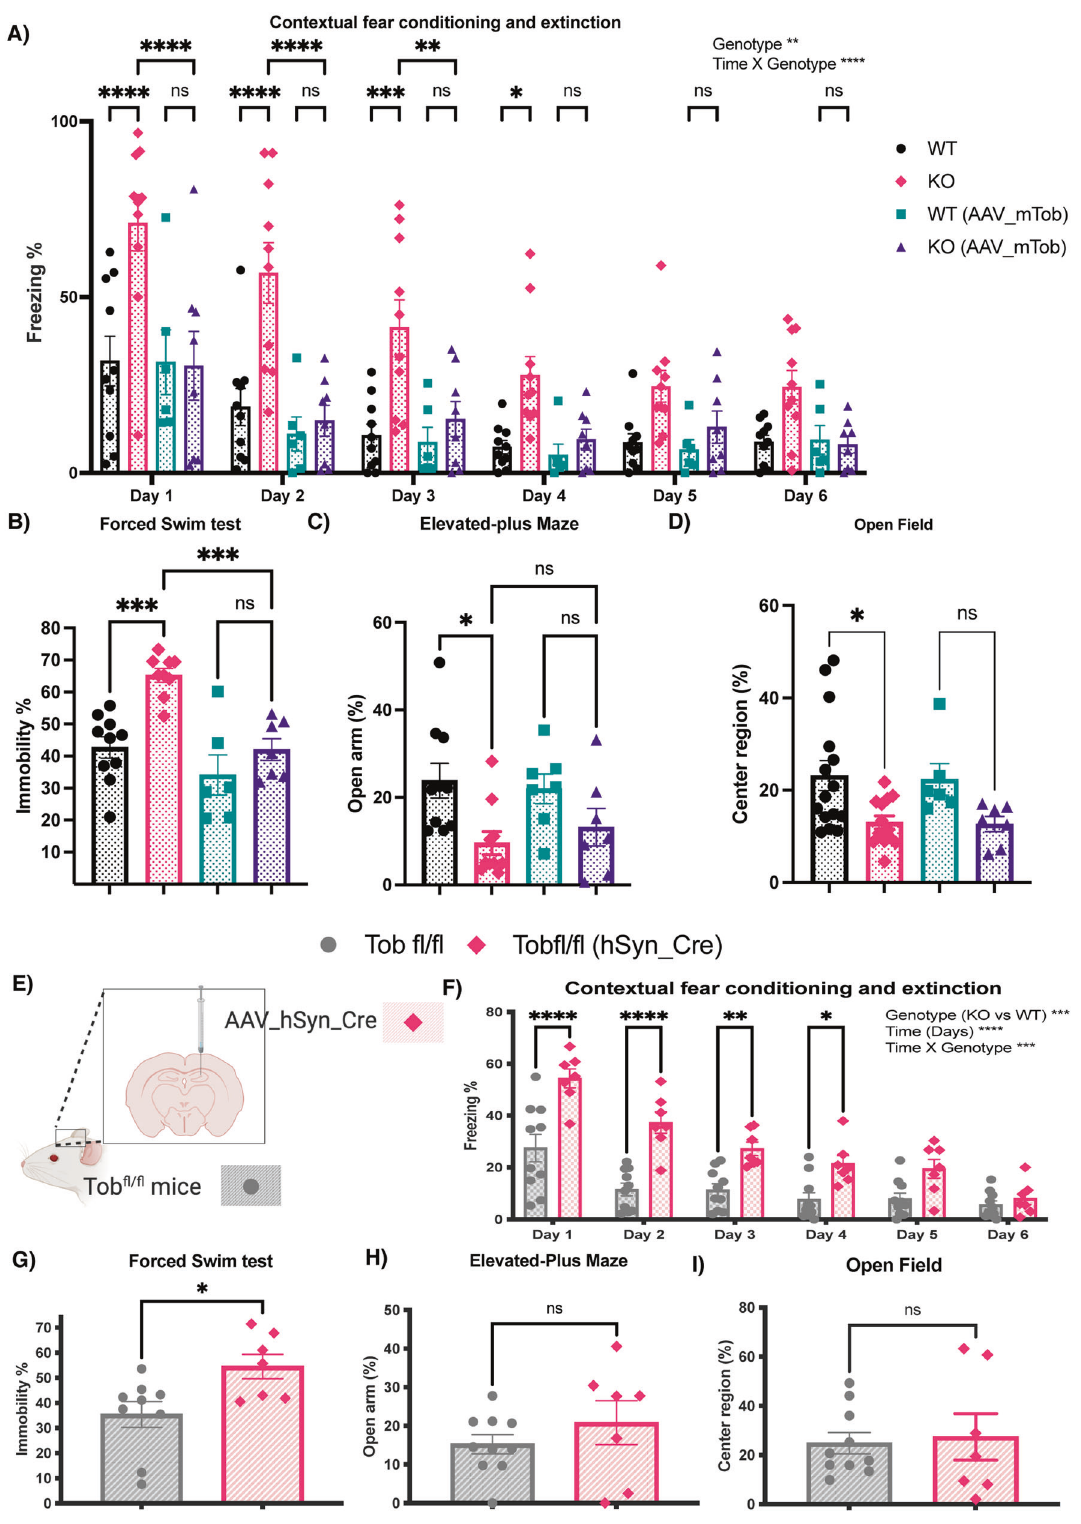
Additionally, fear-induced ERK phosphorylation was inhibited in hippocampi of KO mice after fear conditioning (F 1,24 = 7.395, p = 0.0120 for Genotype effect) (Figs. 5F, G, S7G). On the other hand, MKP-1 protein levels were elevated in KO mice (F 1,3 = 12.25, = 5.358, p = 0.0216 for p = 0.0395 for Genotype effect; F 3,9 Time × Genotype; WT vs KO 1 h p = 0.0124, 3 h p = 0.0029).